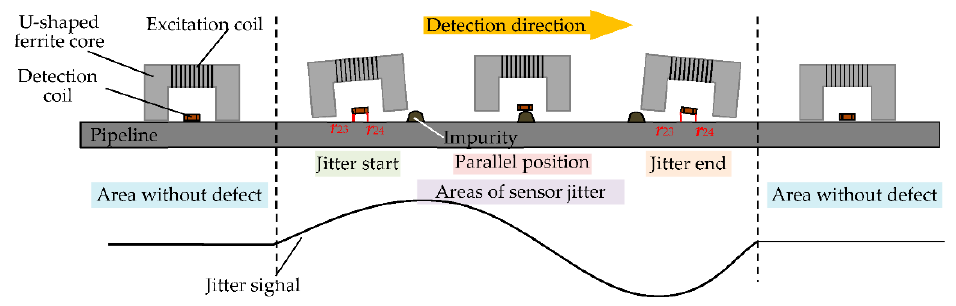
Figure 2. Jitter process of the balanced-field electromagnetic technique sensor.